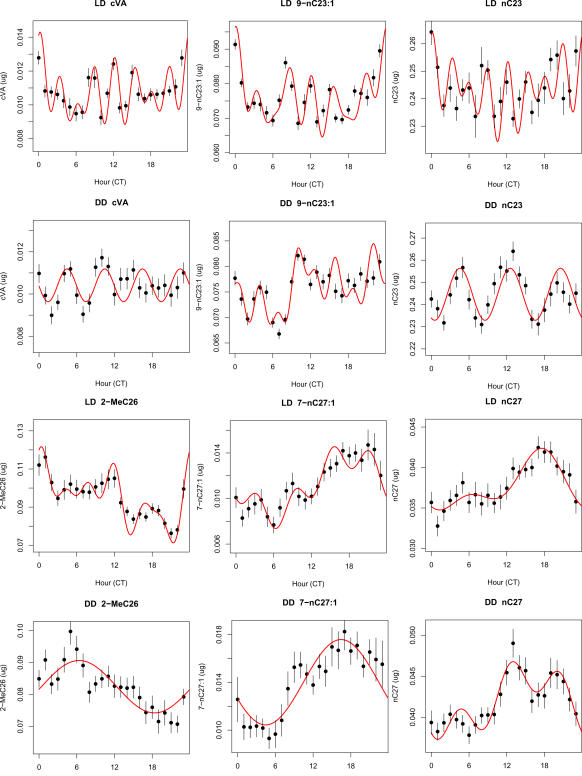
Temporal variation for representative compounds in LD and DD.Curves represent all significant frequencies in a stepwise regression of Fourier components on the raw (unsmoothed) data. Points shown are means from a central moving average filter, ±1 s.e.m. Filter bandwidth is 3, except for curves with significant 3 hour periodicity, where bandwidth of 2 was used (top row). Note 3-hour oscillations centered around peak at lights off (ZT 12) for the three short-chain compounds in LD (significance of 3-hour component for cVA, p3<2.3e-10; 9-C23∶1 p3<3.3e-05; for C23, p3<3.3e-04). In DD, only 9-C23∶1 retains a 3-hour component (p3<3.1e-03). For the three C27 compounds in LD the 24 hour period was most significant in LD (7-C27∶1, p24<1.0e-07; C27, p24<4.7e-05; C27Br, p24<4.6e-05) and in DD (7-C27∶1, p24<4.5e-07; C27, p24<1.2e-05; C27Br, p24<2.6e-05). Both the alkene and methyl-alkanes C27 compounds also had significant 6 hour components in LD, but not in DD. All p values derived from F2,272 ratios from regression in LD, F2,341 in DD (see Methods).